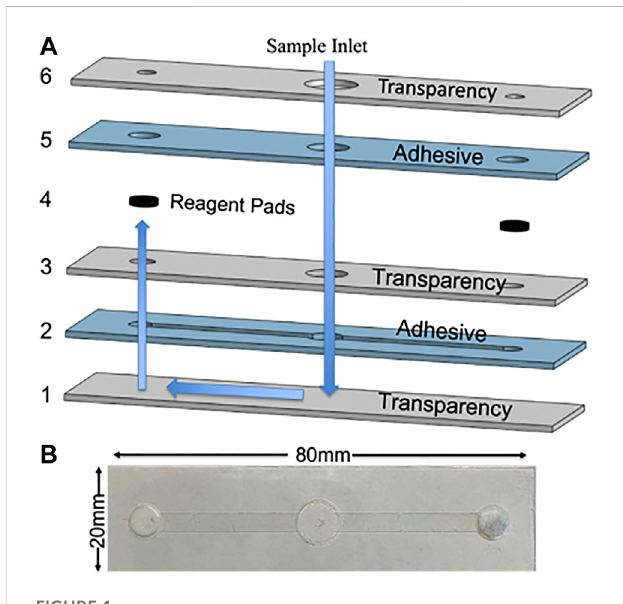
FIGURE 1 (A) CADrenderingofdeviceassemblywithalternatingtransparency and double-sided adhesive layers with blue arrows to indicate the operation of the fl uid fl ow through the device. (B)